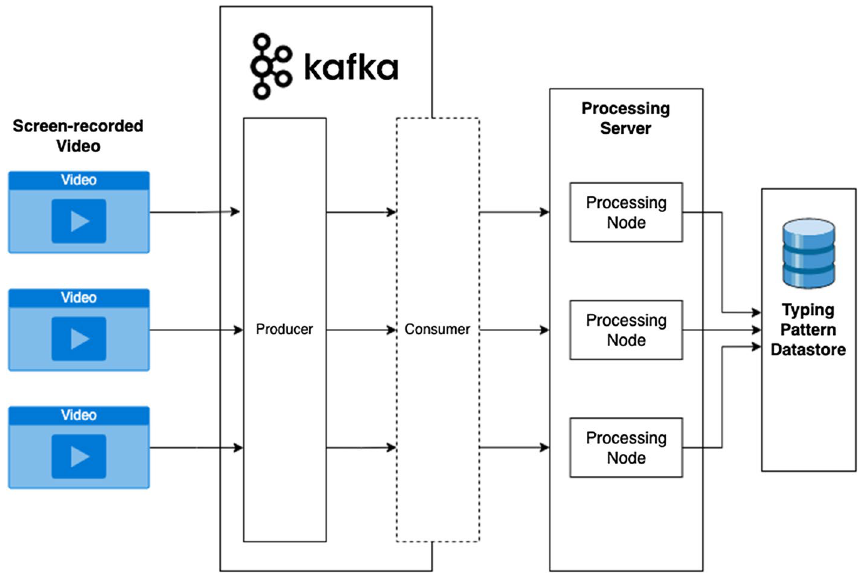
Fig. 20 Big Data pipeline for keystroke extraction